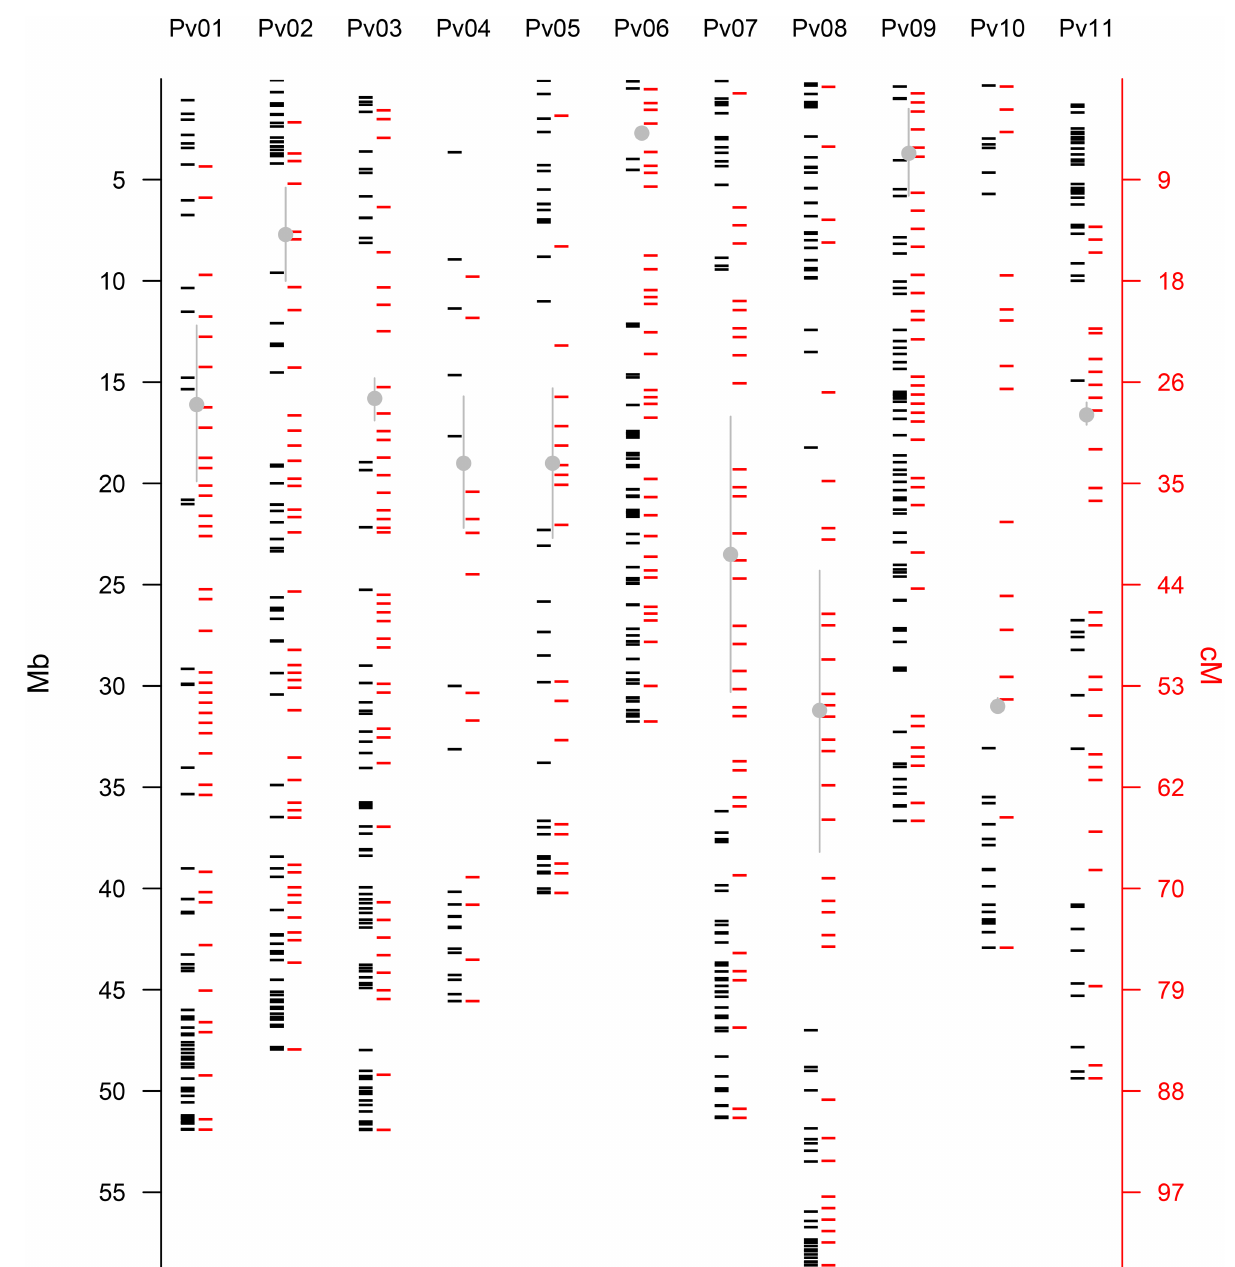
Fig 1. Relationship for each chromosome (labelled as Pv) between linkage map position (on the cM axis) and physical map position (on the Mb axis) for 11 chromosomes of common bean based on the SNP marker mapping described in this text and the BAT93 x JaloEEP558 recombinant inbred line